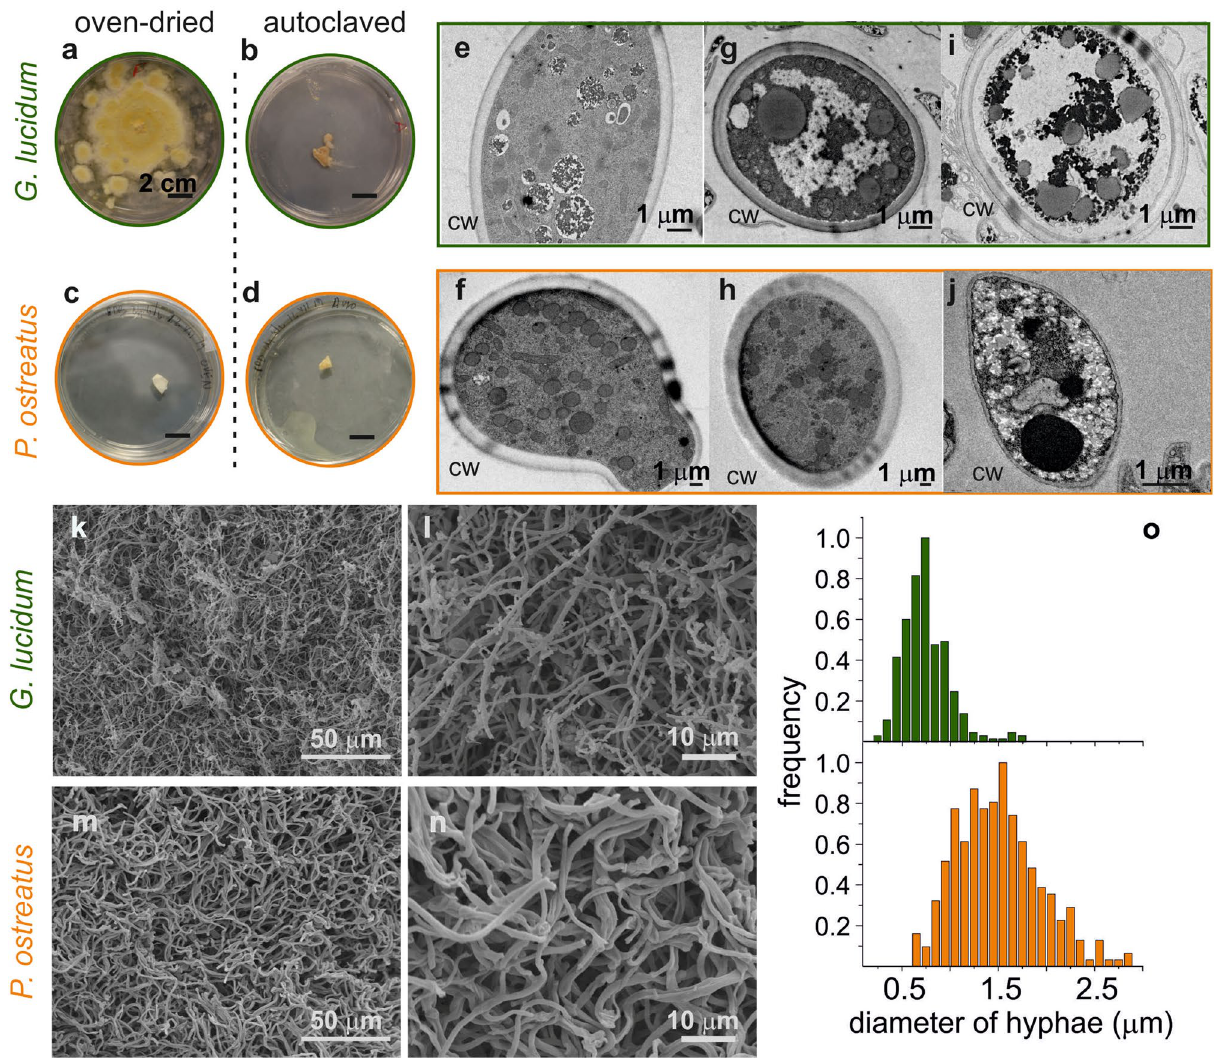
Figure 2. Morphological features of mycelia. ( a – d ) “Re-growth” experiments with oven-dried and autoclaved mycelia ( e – j ) TEM images of mycelia as grown ( e , f ), dried in oven ( g , h ) and autoclaved ( i , j ), CW = cell wall . ( k , n ) SEM images of autoclaved mycelia; ( o ) distribution of hyphal diameters as calculated from the SEM images of the autoclaved